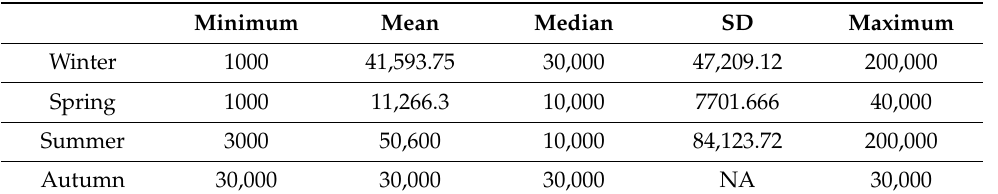
Table 6. Factors associated with the orchard damage ( n = 130) by wild boars used in the orchard damage-based PCA. The values shown include the means, medians, standard deviations, minimums, and maximums of the continuous factors used in the orchard damage-based PCA.